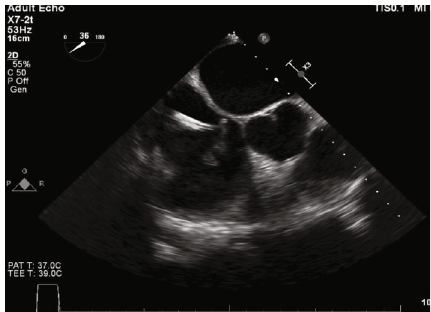
Figure 1: Large mobile thrombus in the right atrium prolapsing into the right ventricle.